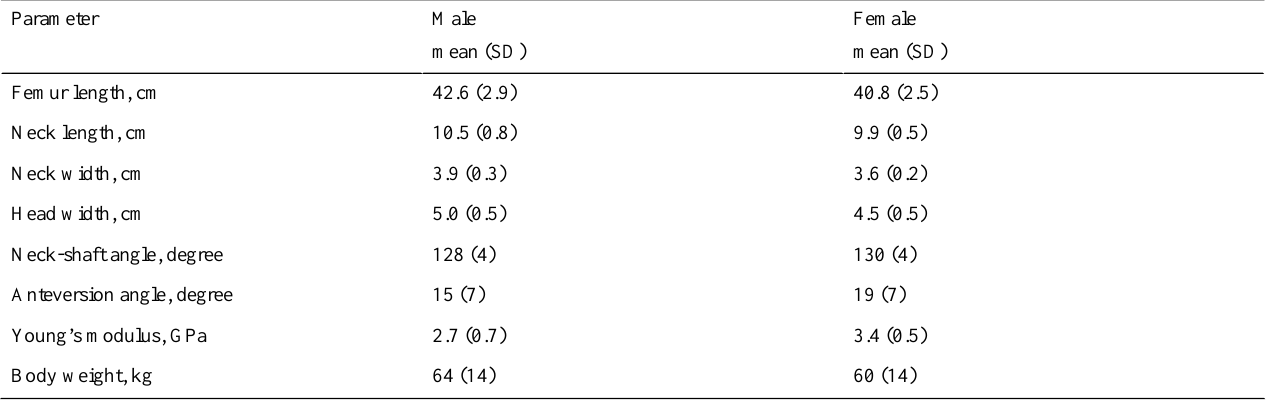
Table 1. Measured bone geometry and bone mechanical properties for men and